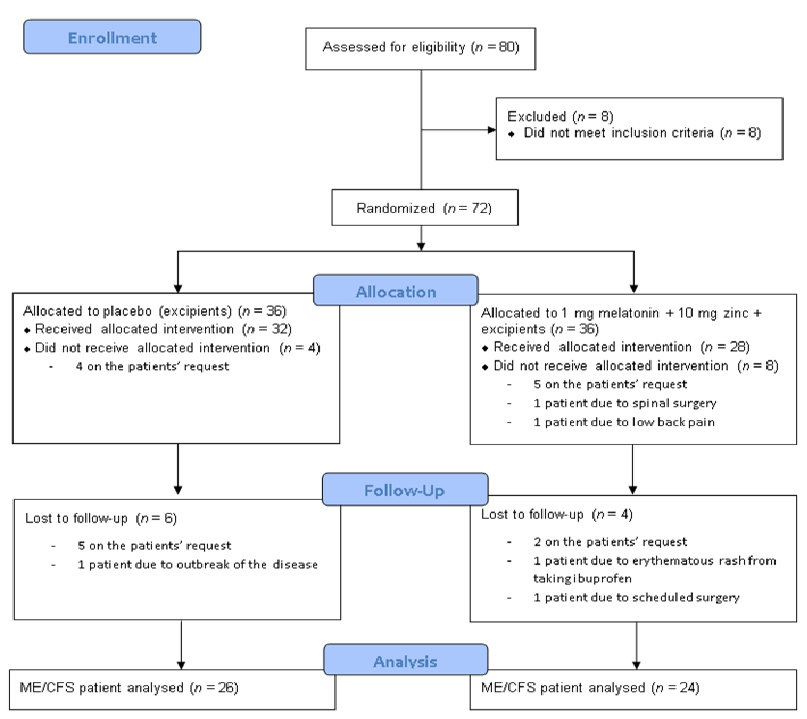
Figure 1. Consolidated Standards of Reporting Trials (CONSORT) flow diagram.